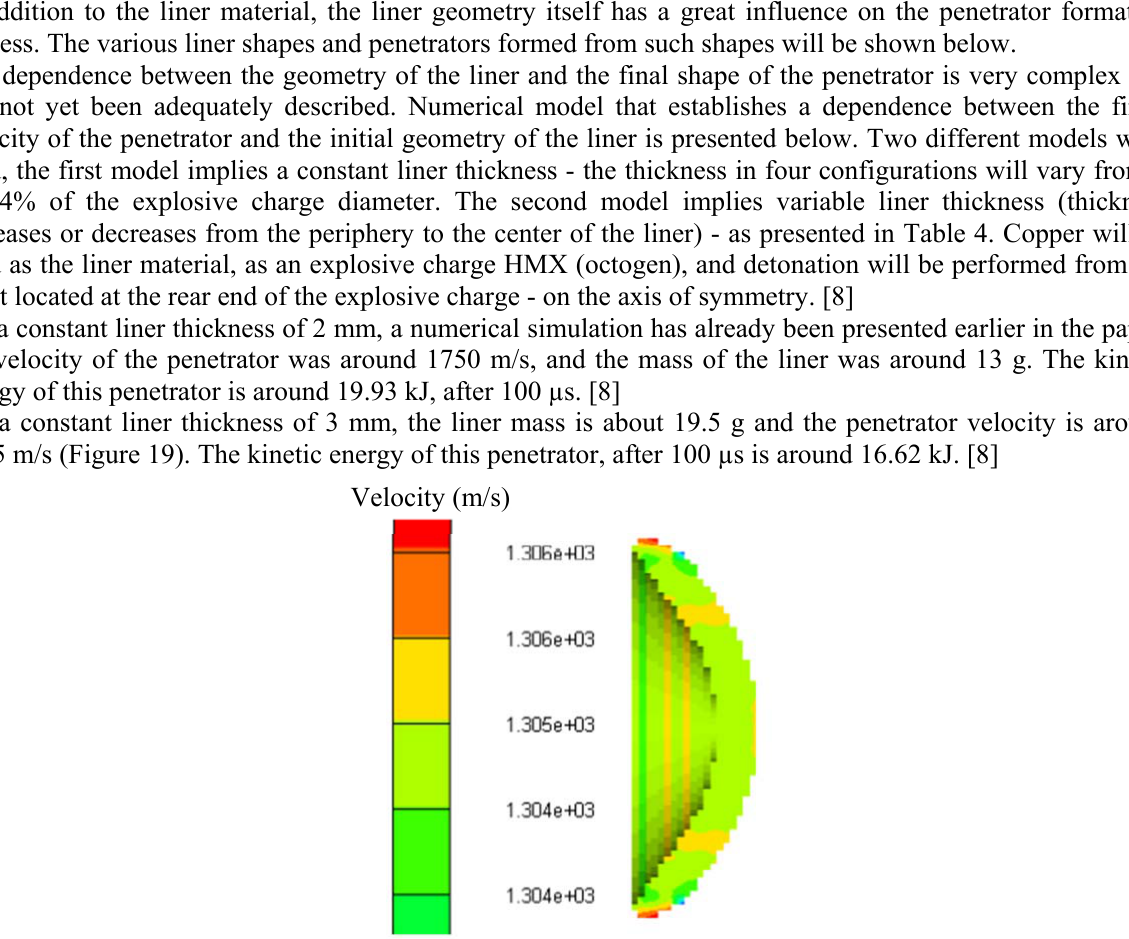
Figure 19. Velocity and shape of copper made penetrator (Autodyn); after 100 µs (liner thickness = 3 mm) [8]